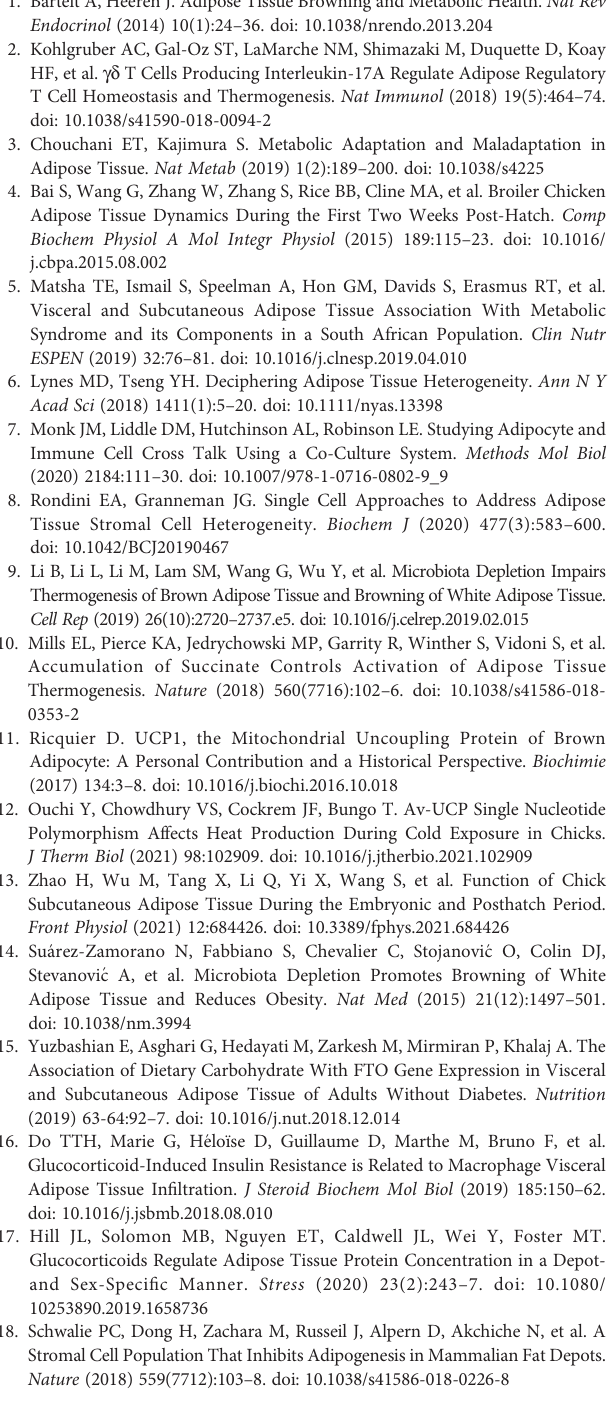
expression of Ccl2, Ccl5, Ccr2 and Ccr5 in RAW264.7 macrophage and 3T3-L1 adipocyte; (C) : Relative mRNA expression of CCL26, CCL5, CCR2 and CCR5